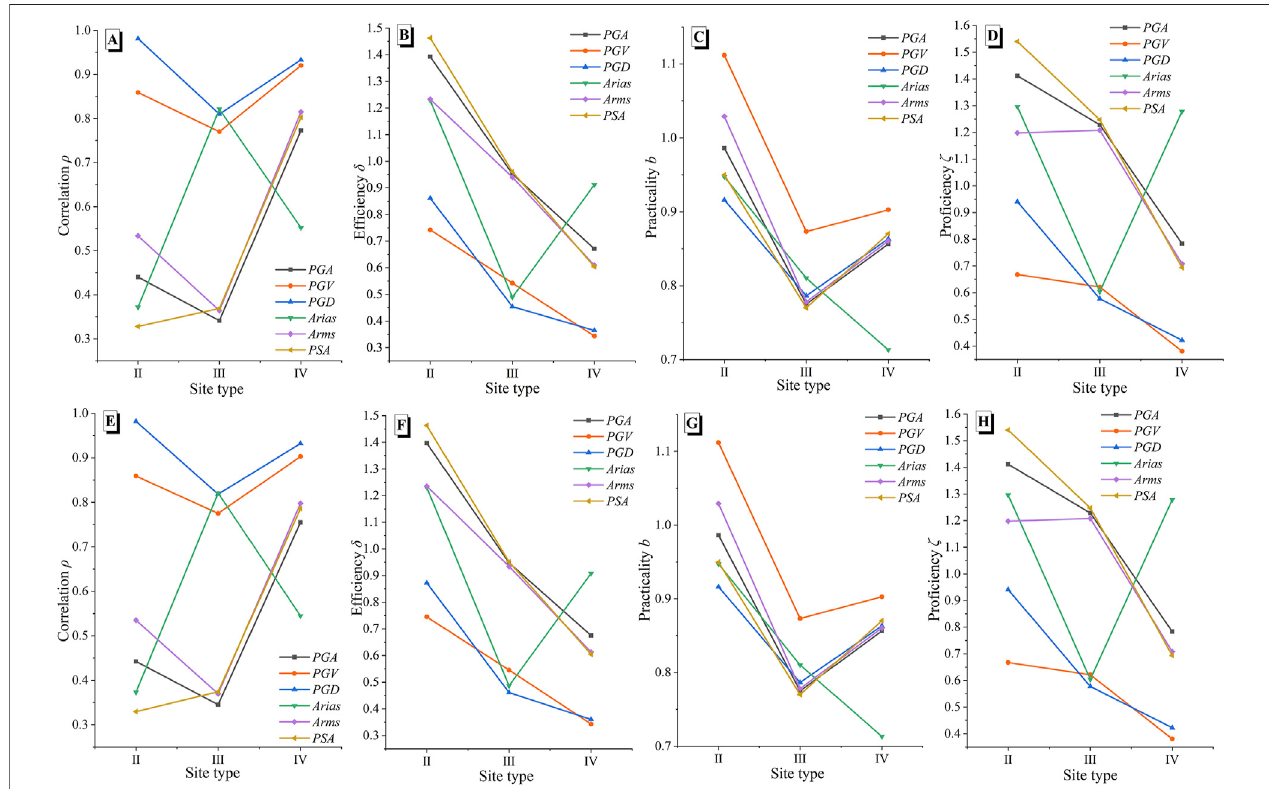
FIGURE 8 | (A – D) The variation law of the intensity measures corresponding to the amount of the ring joint opening and (E – H) the variation law of the intensity measures corresponding to the dislocation.